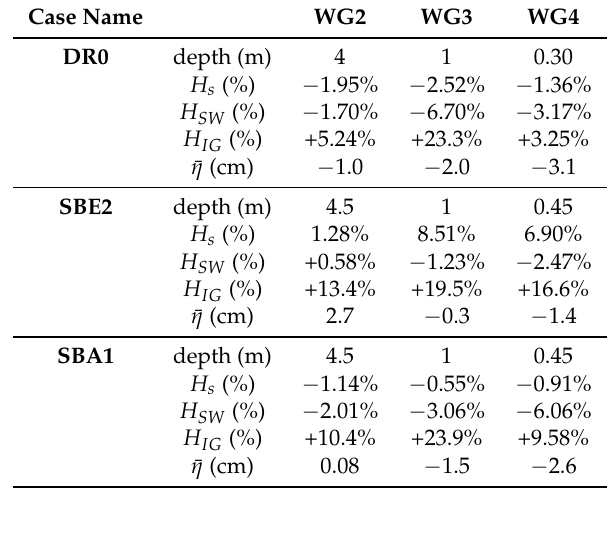
Table 2. Relative error of H s , H SW , and H IG , and absolute errors of the setup ¯ η at the different wave gauges locations. The still water level is indicated for reference.